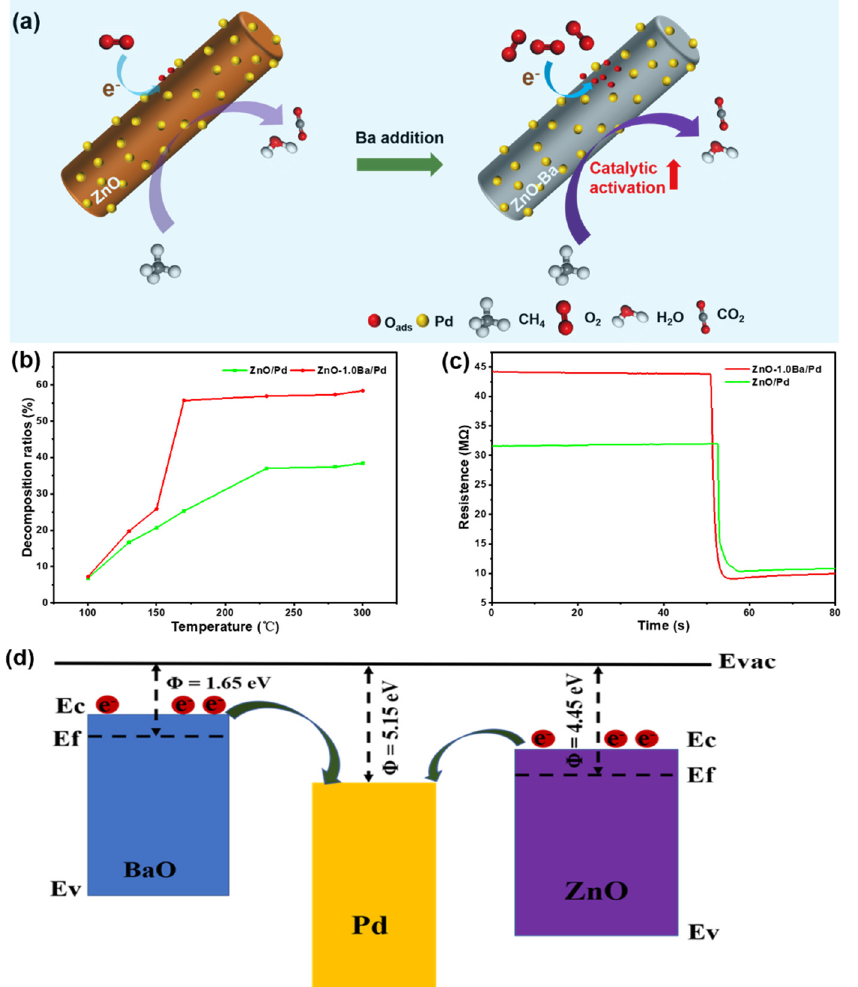
Figure 6. ( a ) Schematic illustration of the CH 4 gas sensing mechanism; ( b ) CH 4 decomposition ratios for ZnO/Pd and ZnO-1.0Ba/Pd at 100–300 °C; ( c ) resistance change curves of sensitive materials be- fore and after target gas injection; ( d ) energy band diagram of BaO, Pd, and